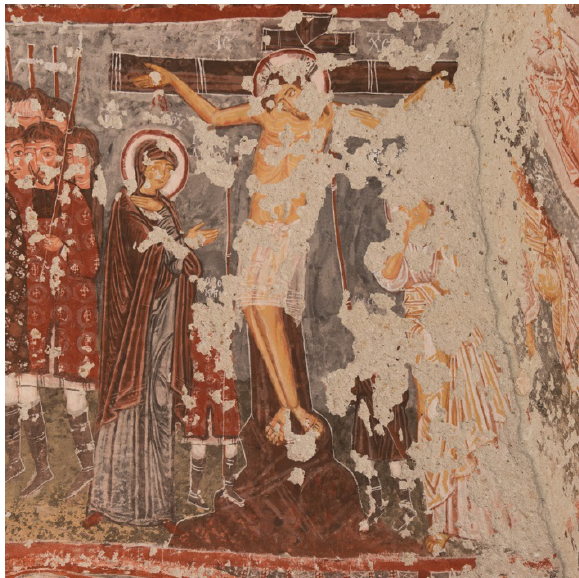
Figure 8. The Crucifixion of Sarnıç Kilisesi (after Virtual Toning) 3) Transfer the part of the icon of St. Mary in Sarnıç Kilisesi (Figure 9) into the Crucifixion in Merymana Kilisesi and Modify the size and color of the icon (Figure